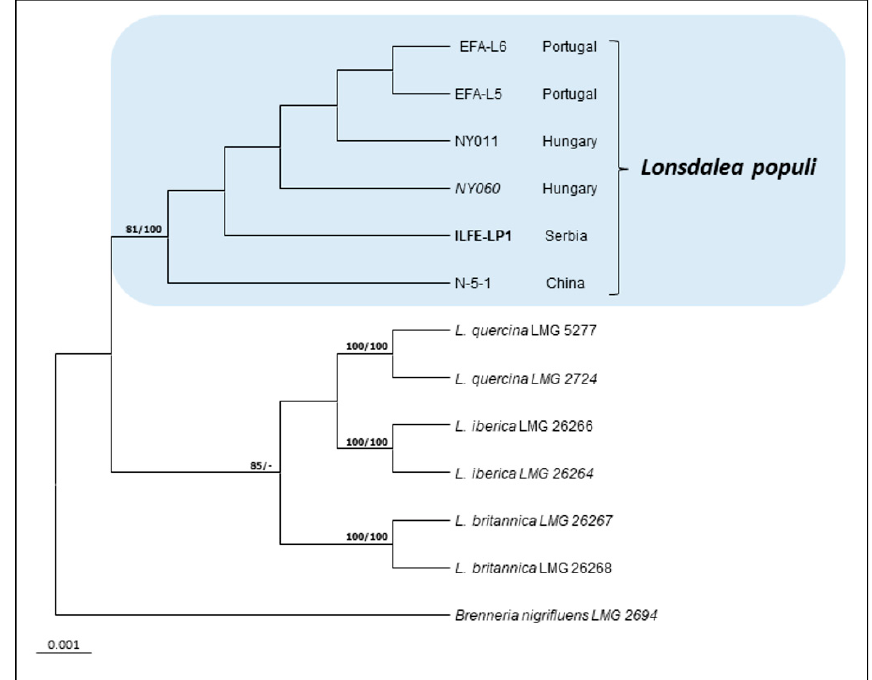
Figure 2. Maximum ‐ likelihood (ML) tree resulting from ML analyses of the concatenated atpD , gyrB and infB gene sequences and showing the phylogenetic position of Lonsdalea populi in relation to its closely related species. The bootstrap support values (ML/MP ≥ 80% (maximum parsimony: MP)) are indicated at the nodes, and the scale bar represents the expected number of changes per site. The tree was rooted to Brenneria nigrifluens . Strain ILFE ‐ LP1 identified in this study is shown in bold and a clade corresponding to L. populi is highlighted.